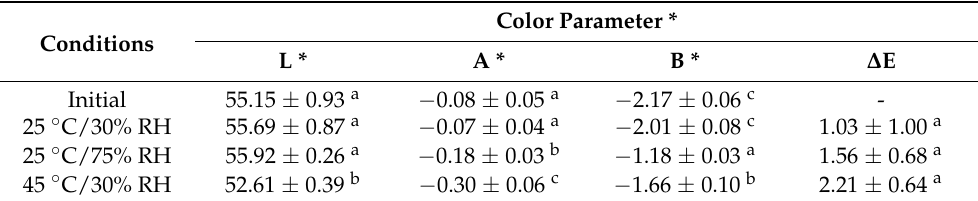
Table 4. Color parameter of CP-F at initial measurement and after storage at various conditions for 12